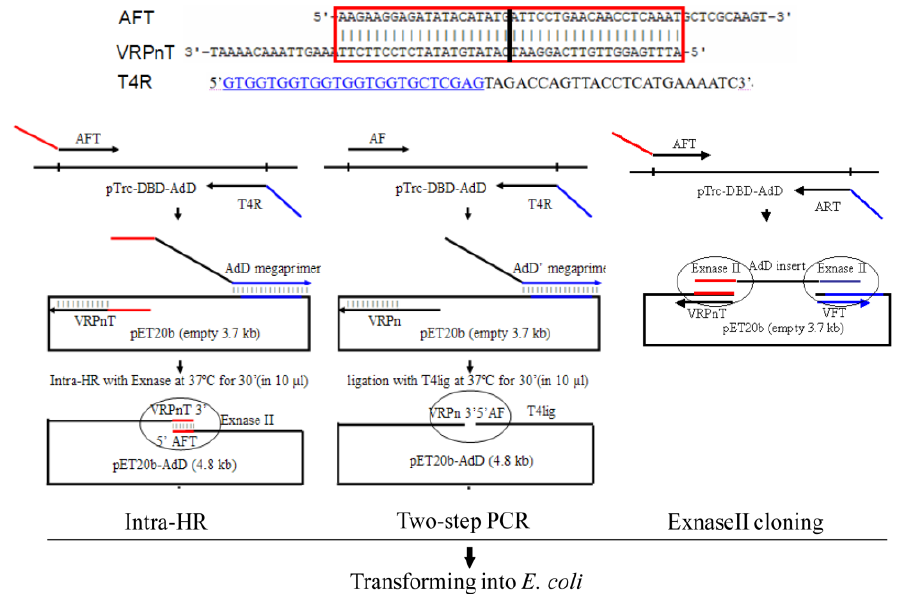
Figure 1. Protocol of the intra-HR (left), the two-step PCR (middle), and the ExnaseII cloning (right). The AFT and VRPnT primers in the intra-HR (left) have complementary 5′-termini (red line), differing from the un-complementary primers of AF and VRPn in the two-step PCR (middle). The primer T4R in both the intra-HR (left) and the two-step PCR (middle) complements to the vector at the insertion downstream (blue line), providing the amplified megaprimer to anneal to the vector in a 2nd PCR. Coupled with the primer VRPnT (left) or the primer VRPn (middle), the megaprimer AdD (left) or the megaprimer AdD ’ (middle) amplify linear plasmid DNAs to have homology (left) or blunt-ended 5′- and 3′-terminus (middle). The intra-molecular homology region contains the expected junction of the vector 3′-end and the insert 5′-end (vertical straight black line in the red box). In the ExnaseII cloning (left), the AFT and ART primers amplify the insert AdD having homology arms (red and blue lines) with the vector amplified by the VFT and VRPnT primers. The intra-HR serves one ExnaseII molecule for intra-molecular HR of one joint (left), differing from two ExnaseII molecules for inter-molecular HR of two joints that of the ExnaseII cloning (right). The plasmid DNAs recombine by recombinase ExnaseII (left and right) or ligate by T4 DNA ligase (middle), and transform into E. coli cells.